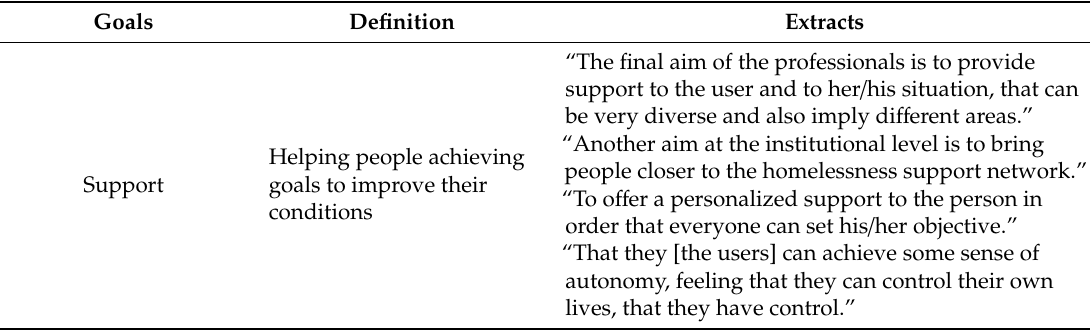
Table 1. Goals of providers working with people experiencing